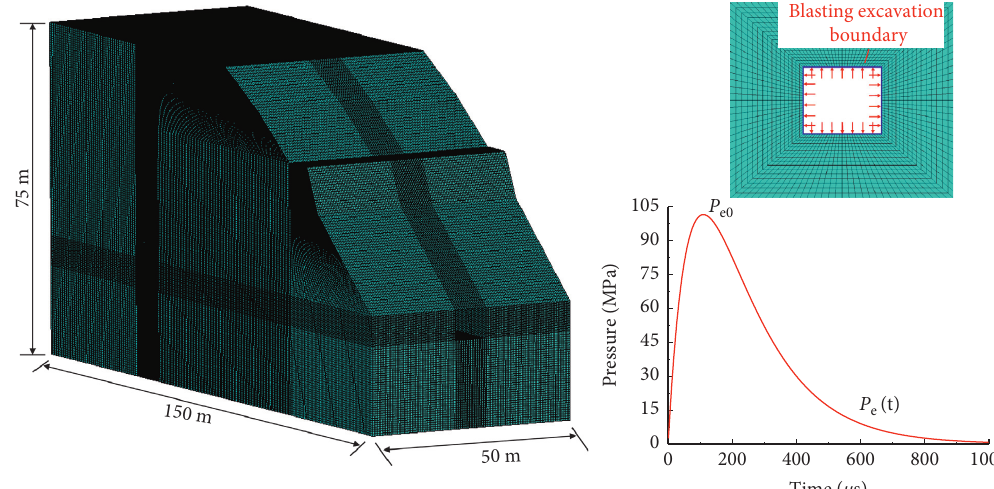
Figure 11: Finite element model used for the numerical